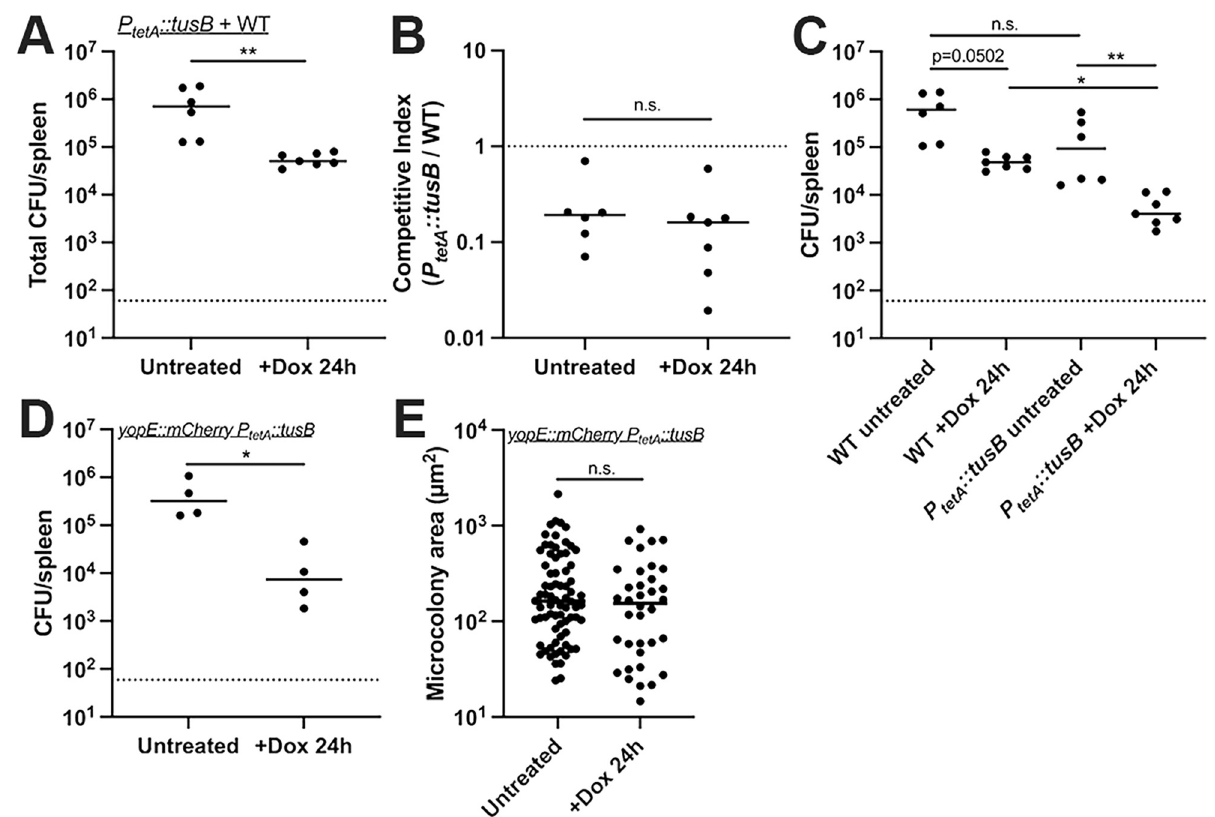
Fig 7. tusB expressing cells have increased susceptibility to doxycycline in vivo . C57BL/6 mice were infected with equal numbers of the WT and P tetA :: tusB strains, infection proceeded for 48h, and mice were either injected intraperitoneally with a single dose of Dox or left untreated. 24h later spleens were harvested to quantify CFUs. (A) Total CFU/spleen, each dot represents an individual mouse. (B) Competitive index values. Dotted line: value of 1; equal fitness between the two strains. Values less than 1 indicate the tusB strain is less fit than WT. (C) CFU/spleen of each strain in the WT + P tetA :: tusB competition experiments. (D) C57BL/6 mice were infected with the yopE :: mCherry P tetA :: tusB strain, infection proceeded for 48h, and mice were either injected intraperitoneally with a single dose of Dox or left untreated. 24h later spleens were harvested to quantify CFUs. (E) Microcolony areas of the yopE :: mCherry P :: tusB strain were quantified from 4 untreated mice and 4 treated mice, each dot represents an individual microcolony. tetA 6–38 microcolonies were quantified in one section for untreated mice, and 1–19 microcolonies were quantified in one section for treated mice. All mouse experiments were carried out on two independent days, horizonal lines depict median values. Statistics: (A, B, D, E) Mann-Whitney; (C) Kruskal-Wallis one-way ANOVA with Dunn’s post-test. �� p < .01, � p < .05, n.s.: not significant.